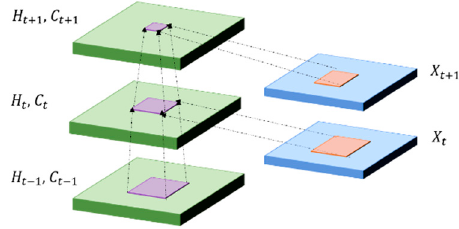
Figure 32. Pictorial diagram for ConvLSTM.